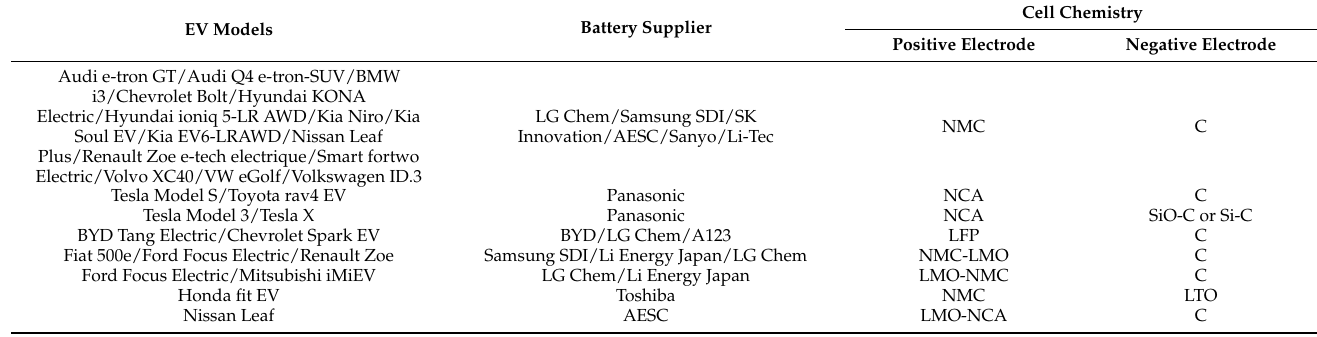
Table 1. A brief summary of various Li-ion battery cell chemistries for EVs, adopted from [3,11]. EV Models Battery